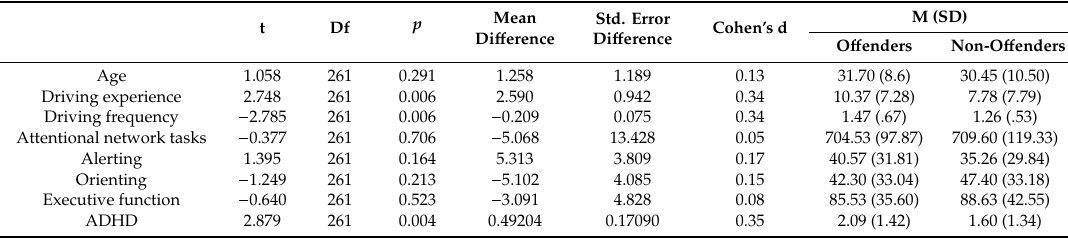
Table 3. Descriptive and inferential statistical indices of demographic, driving-related information, and attentional network performance between tra ffi c o ff enders and non-o ff enders.